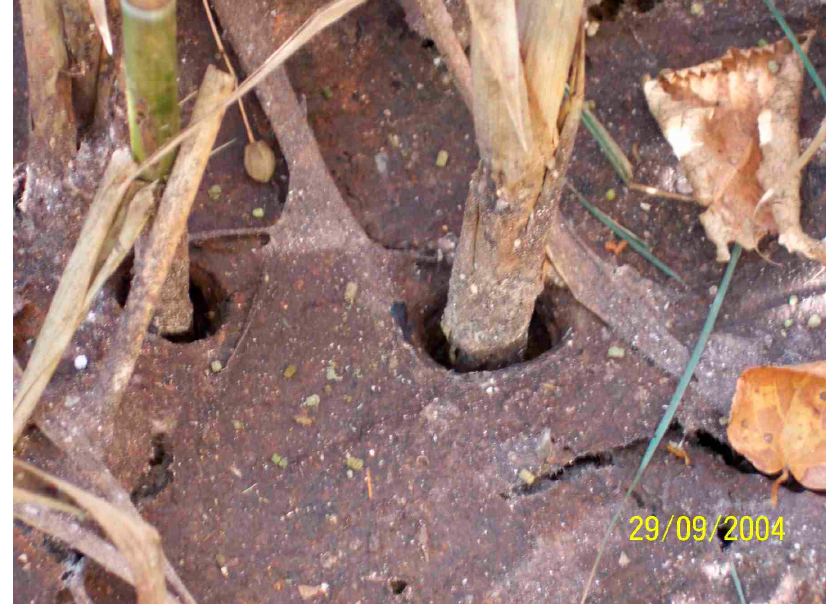
Figure 4. Openings in the sludge around the stems of Phragmites australis caused by the movements of the plants in the wind. These openings are important for maintaining a high water permeability in the sludge layer accumulated on the surface of the bed (photo: H.